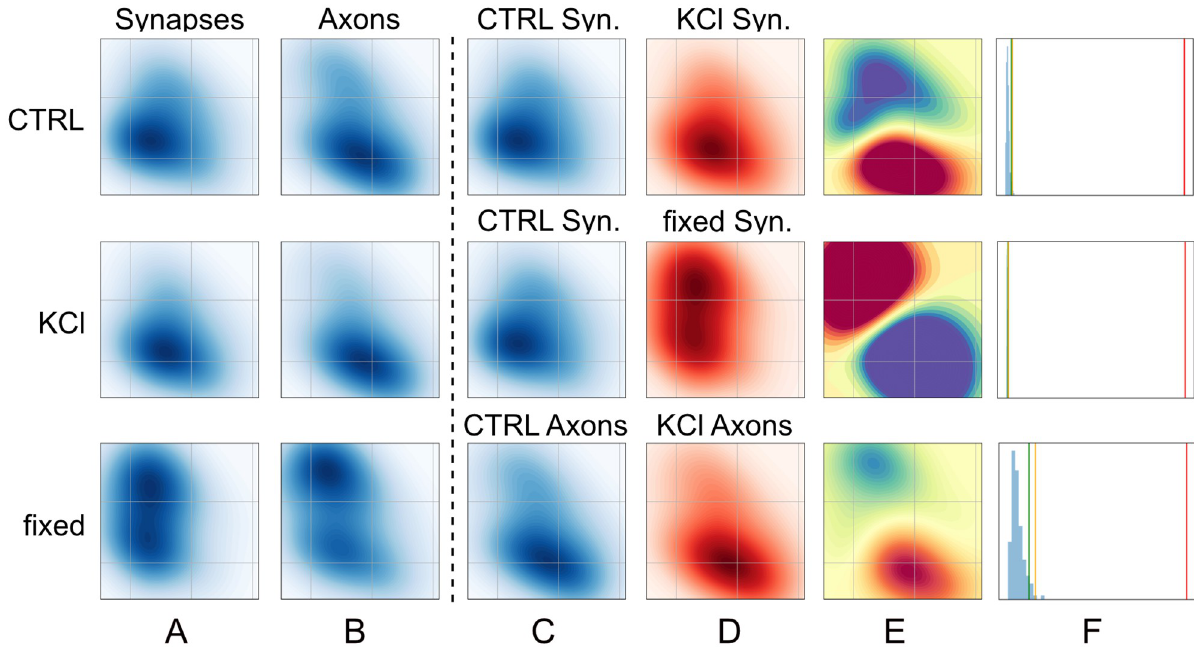
Fig 5. Latent space occupation & statistical testing. Left part: ( A ), ( B ) Latent space occupation densities of α Syn:Eos4 trajectories observed in synapses and axons, in the three experimental conditions (control, high KCl, fixed). Right part: each row is one comparison of two sets of trajectories. ( C ), ( D ) Side by side comparison of the latent space occupation densities of the two sets of trajectories used in the comparison in E and F. ( E ) Witness function of the comparison. The colour scale is preserved across rows. ( F ) Histograms illustrating the statistical test based on the MMD. The green and yellow vertical lines represent the top 5% and top 1% quantiles of the null distribution of the squared MMD, respectively, while the red line shows the squared MMD for the experimental data.